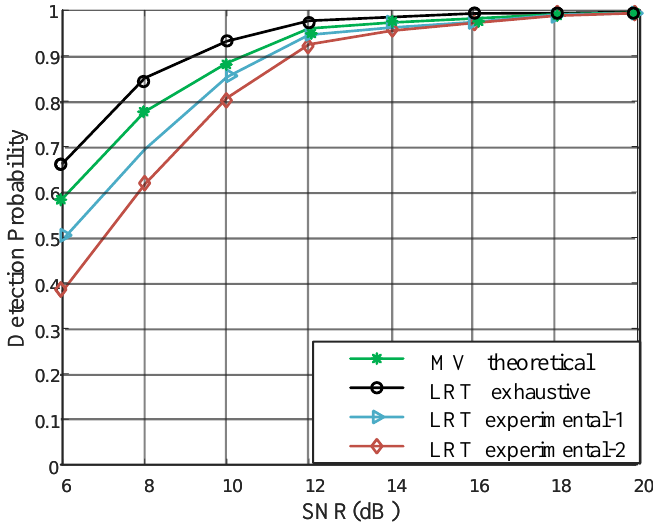
Figure 2. Likelihood ratio test (LRT) and majority voting algorithm